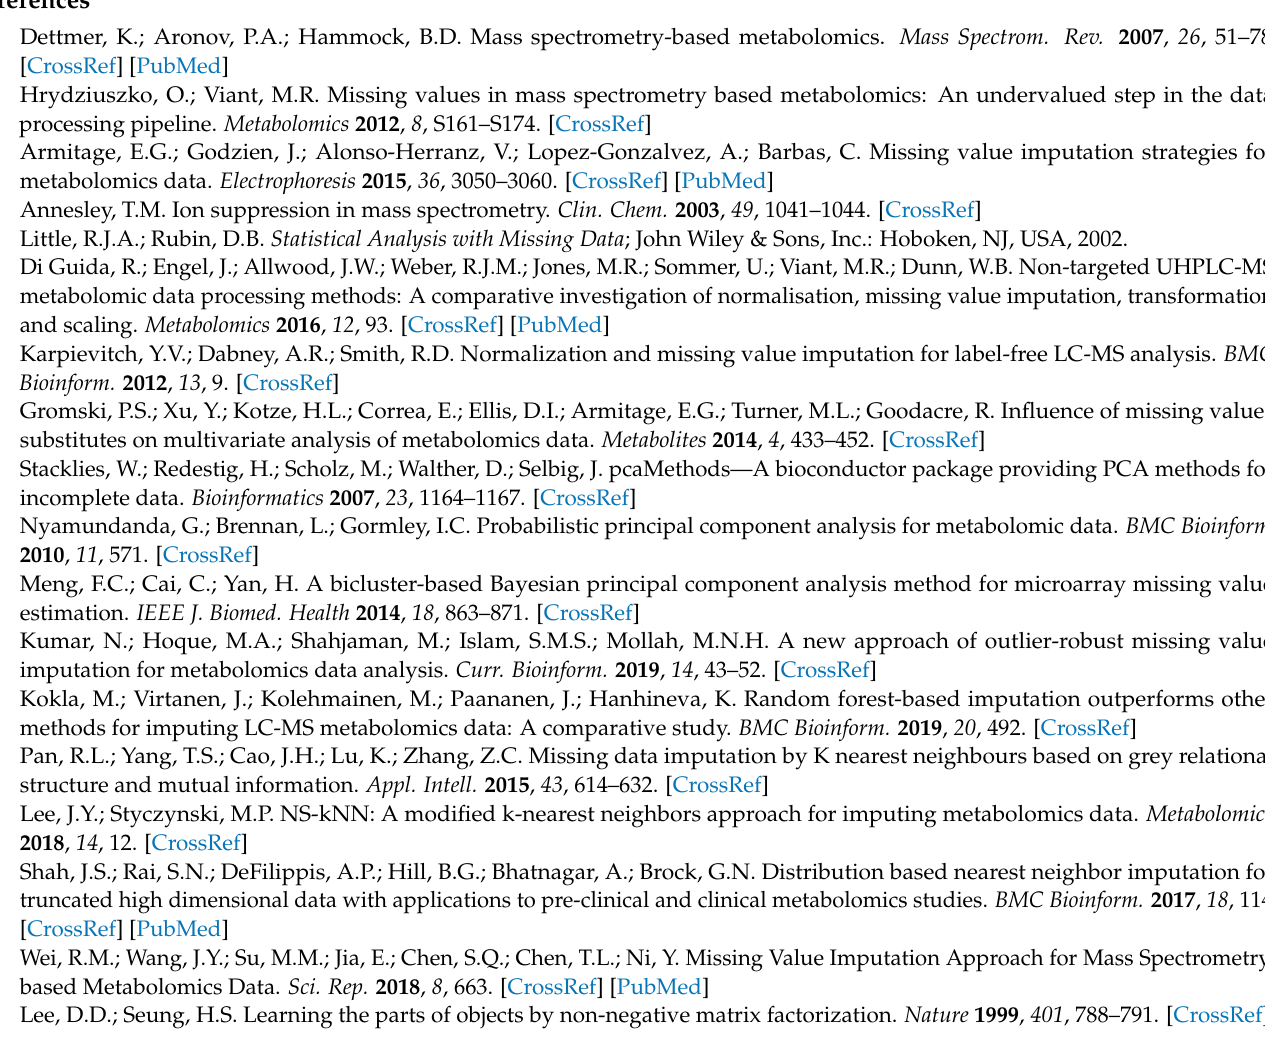
Supplementary Materials: Figure S1: The distribution of NAs in real datasets. Figure S2: Imputation results for the metabolomics dataset of colorectal cancer. Figure S3: Changed metabolites before and after NAs imputation. Table S1: Performance of four different methods on Dataset I-IV and CRC